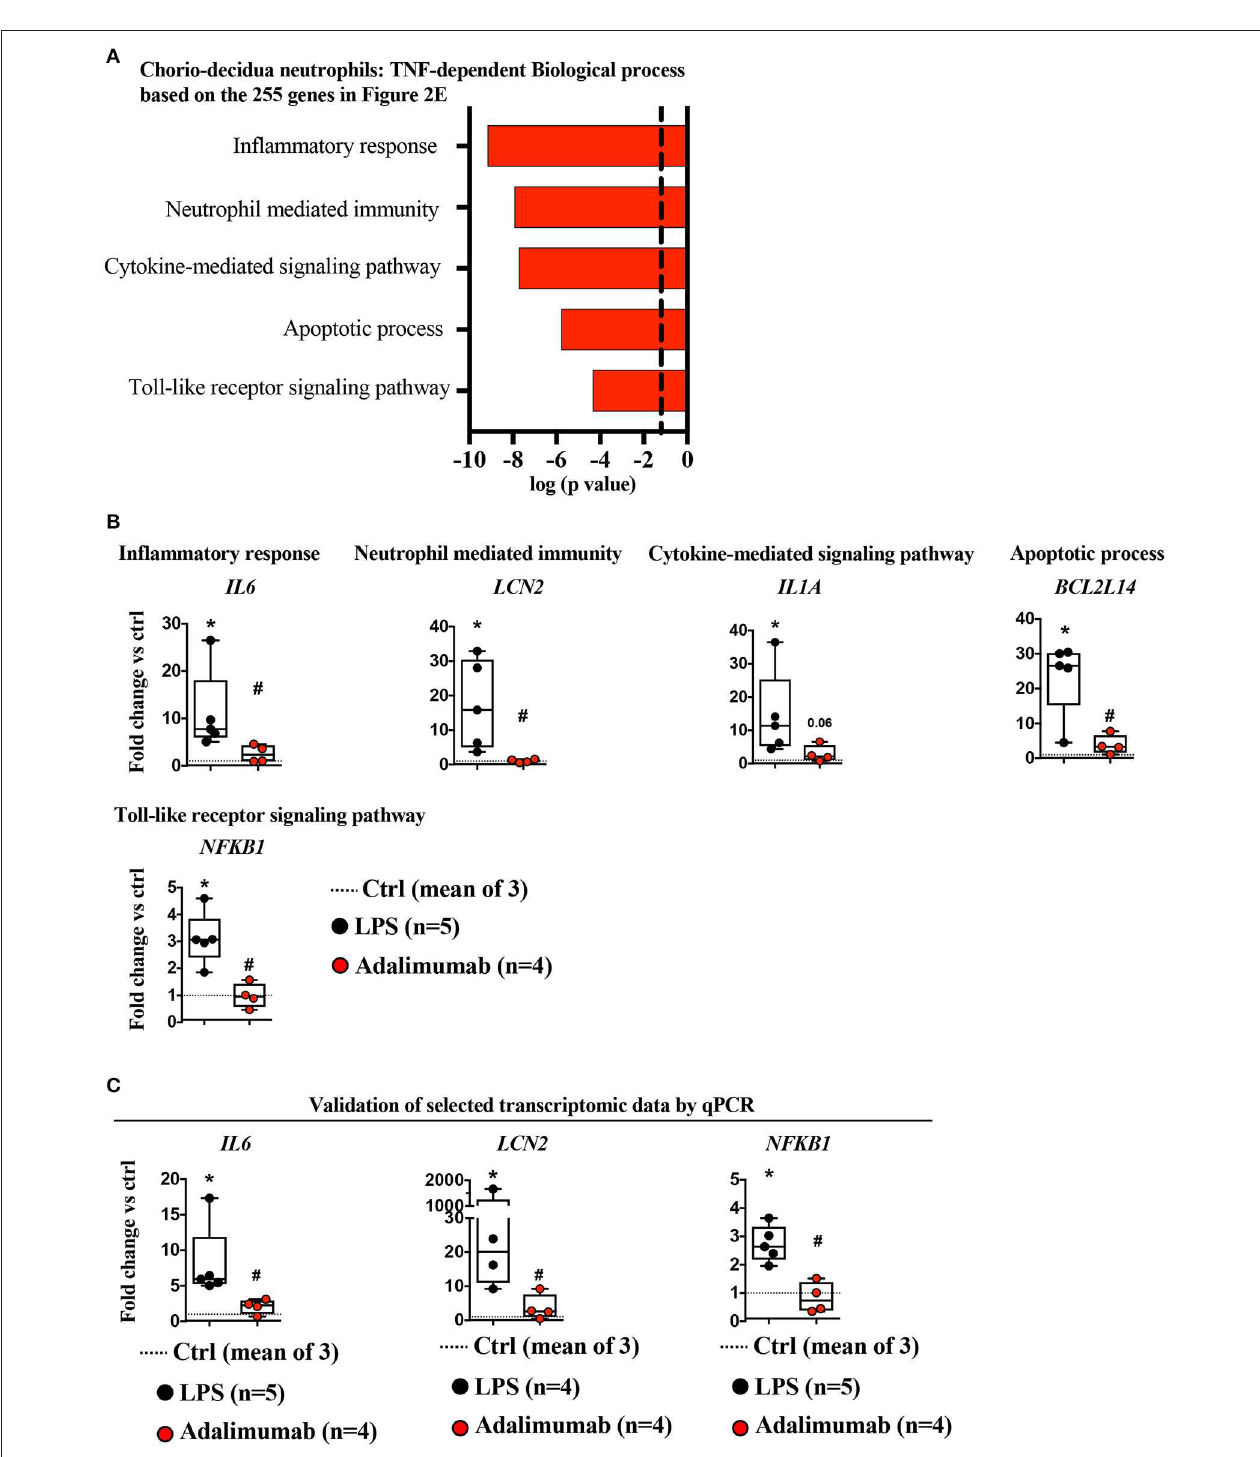
FIGURE 3 | TNF-signaling inhibition decreased neutrophil mediated immunity. (A) Biological processes of LPS-induced genes ( ≥ 4-fold vs. controls) that were significantly down-regulated by Adalimumab ( ≥ 1.5-fold decrease vs. LPS) designated as “TNF-dependent genes,” determined using Enrichr. Dotted line represents gene-expression values representing the mean of three control animals. (B) Representative genes representing biological processes inhibited by Adalimumab shown in (A) (dotted-line represents the mean of 3 Ctrl; LPS n = 5; Adalimumab n = 4). (C) Validation of selected transcript expression by qPCR analysis. mRNAs were isolated from FACS-sorted chorio-decidua neutrophils from Ctrl (dotted-line represents the mean of 3 Ctrl), LPS- ( n = 4–5), and Adalimumab-treated animals ( n = 4). qPCR was performed using rhesus-specific Taqman probes. The values were first internally normalized to the endogenous 18S RNA. For each gene, the box plot (median and 5–95th percentile and outliers) shows fold-change of gene expression in chorio-decidua neutrophils normalized to control chorio-decidua neutrophils (dotted-line represents the mean of 3 ctrl). * p < 0.05 vs. ctrl; # p < 0.05 vs. LPS (Mann–Whitney U -test).